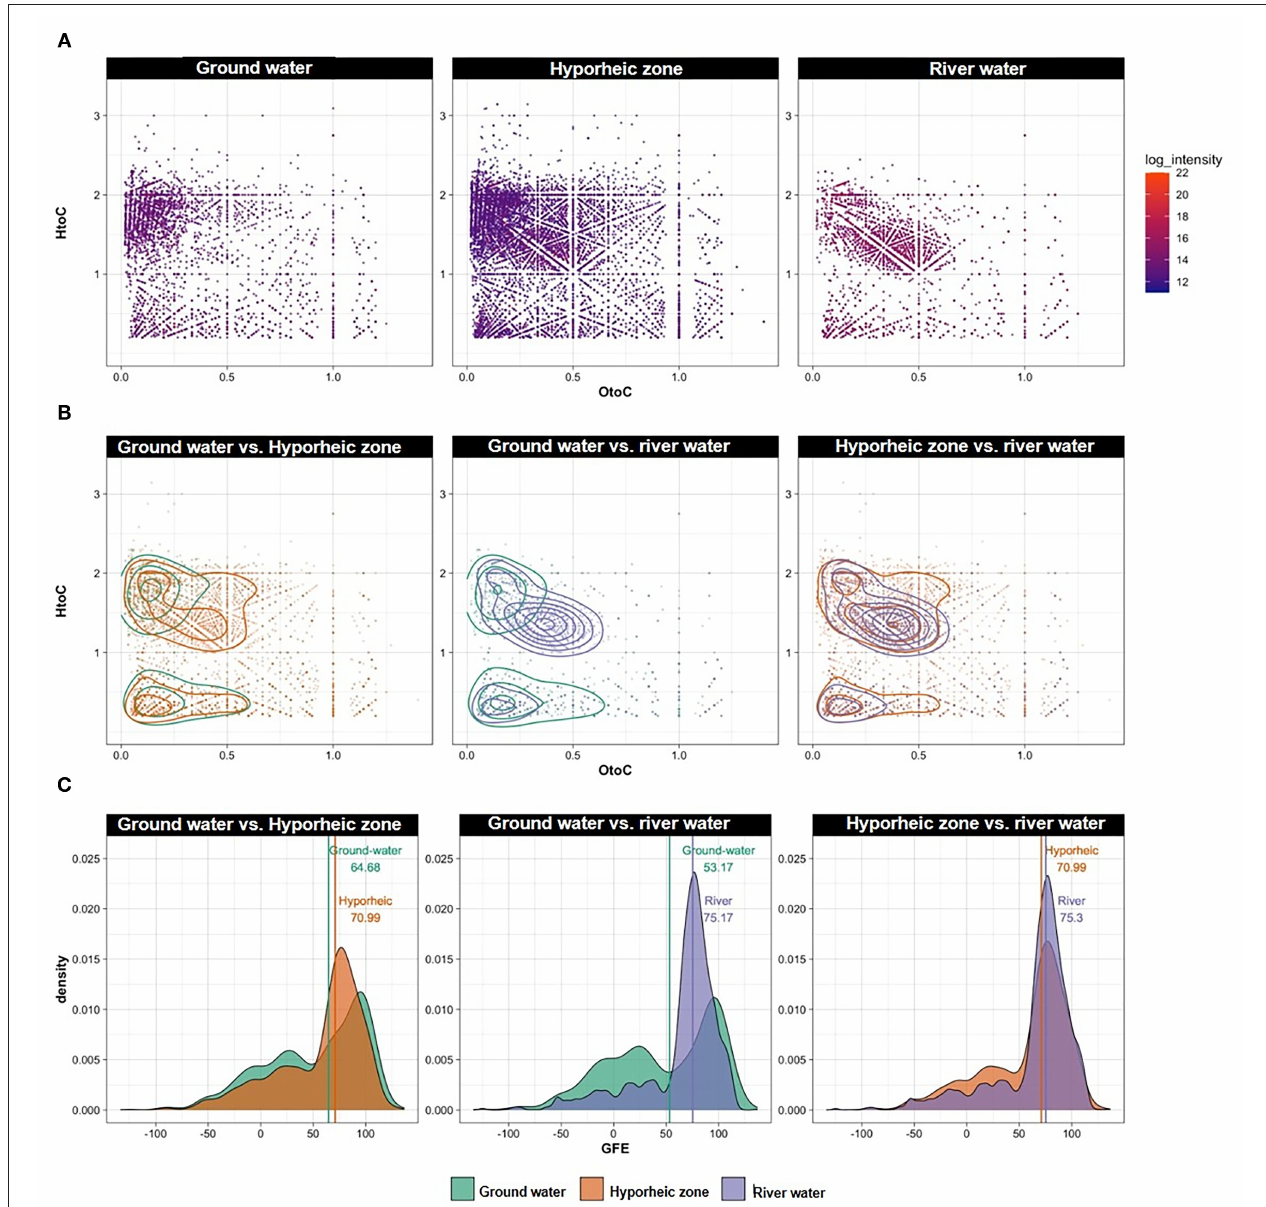
FIGURE 4 | (A) Van Krevelen (VK) diagrams of all peaks observed in each system combined over different river stages, ground water wells and piezometers locations; (B) VK diagrams (with contoured lines) and (C) Gibbs free energy (GFE) ridge lines of unique peaks (i.e., peaks present in one ecosystem but not the other), filtered as pairwise comparisons between the following groups: ground water vs. river water, ground water vs. hyporheic zone, hyporheic zone vs. river water, regardless of river stage and piezometers location. Lines along with numbers in panel C represent the median of each